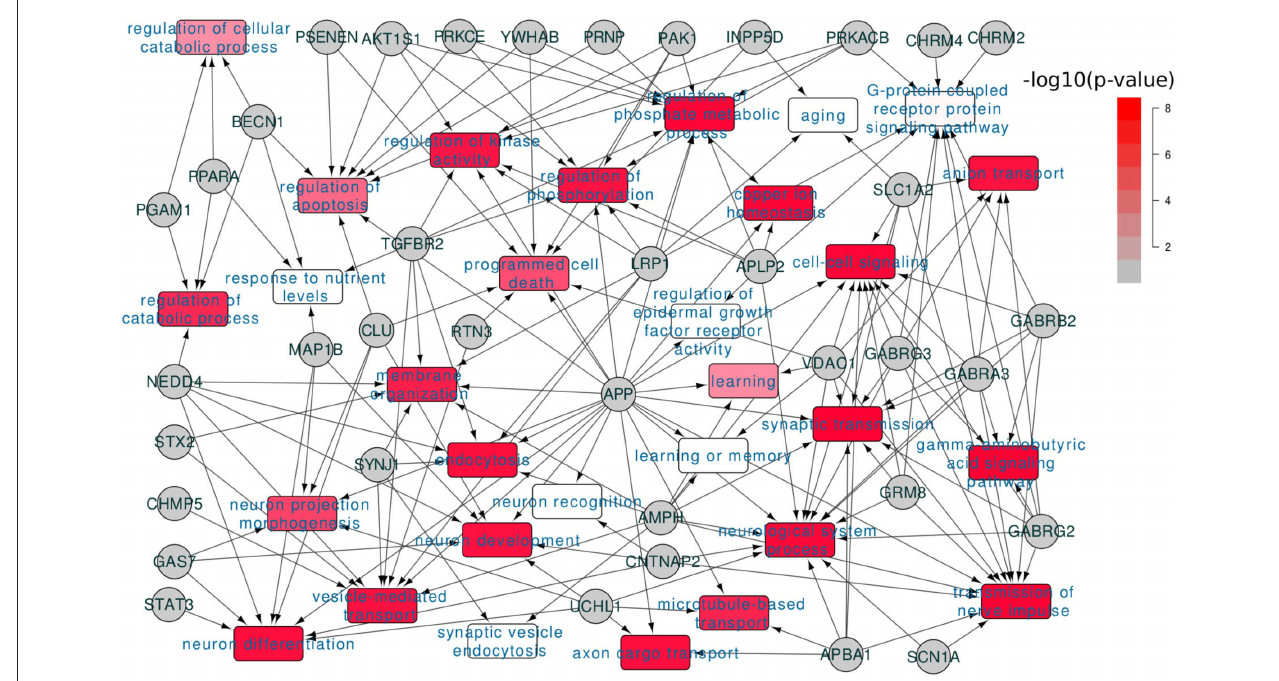
FIGURE 2 | Functional involvement of dysregulated AD genes. 68 dysregulated AD genes were annotated for their functional involvement based on the Gene Ontology annotation; the colors of GO terms indicated the enrichment